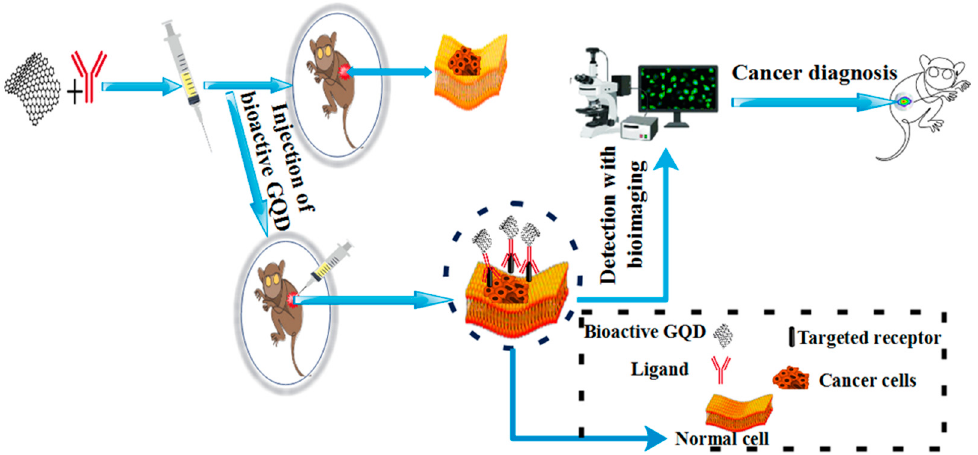
Figure 11. Diagnosis of cancer using bioimaging based on bioactive GQD.